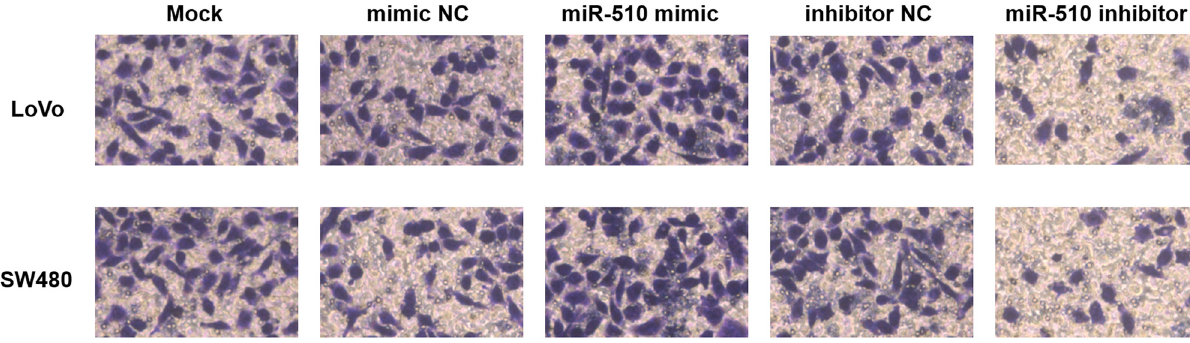
Figure A2: Representative images of the invasion of LoVo and SW480 cells by the Transwell